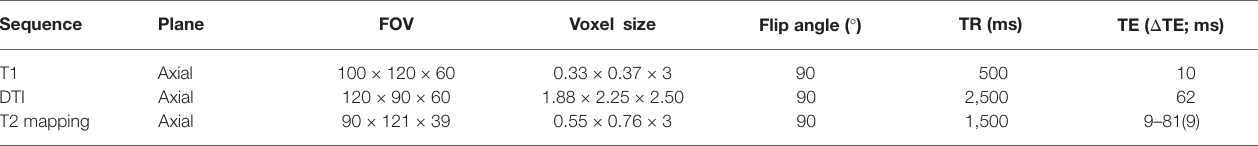
TABLE 1 | Sequence parameters for T1, diffusion tensor imaging (DTI), and T2 mapping.